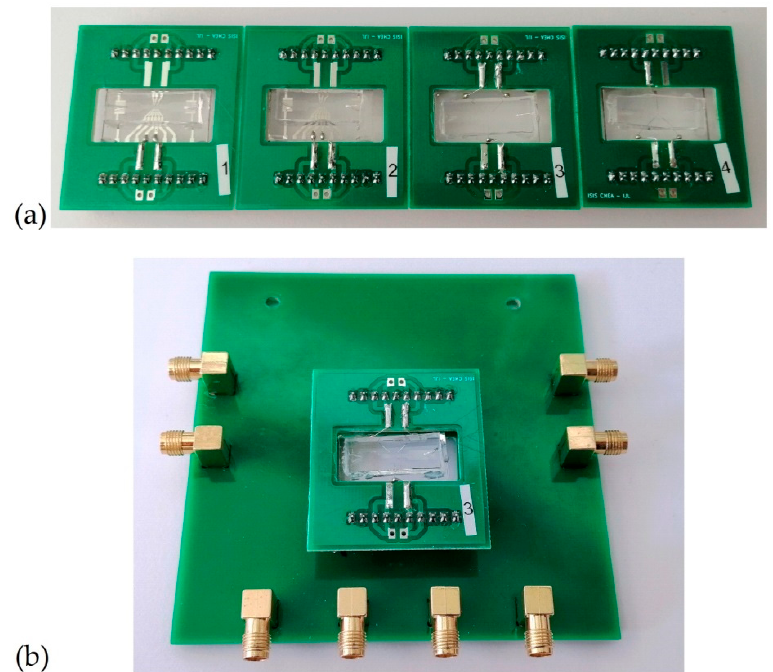
Figure A3. ( a ) Photograph of the cytometry biosensors connected on an individually numbered PCB. Sensors S1–S2 were first generation and S3–S4 were second generation. ( b ) Photographs of a sensor plugged into a test plate.